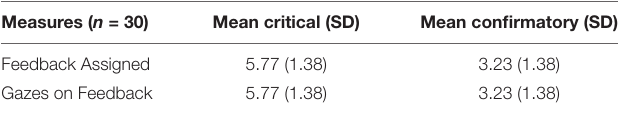
TABLE 2 | Means and standard deviations (in seconds) of gaze duration by letter and by word for each feedback valence.